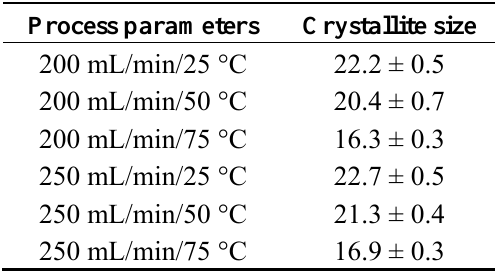
Table 1. Crystallite size in dependence on the process parameters.